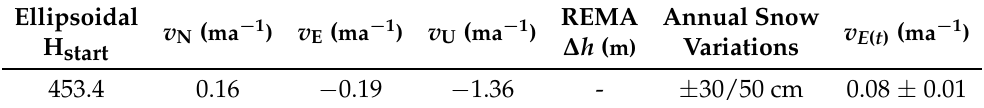
Figure 8. Eulerian surface elevation at the ROB1 antenna location over the 05-12-2012 to 14-01- 2016 period. Table 2. ROB1 results summary. Non-reported 2 σ uncertainties are < 0.005 ma − 1 in all north, east, and up